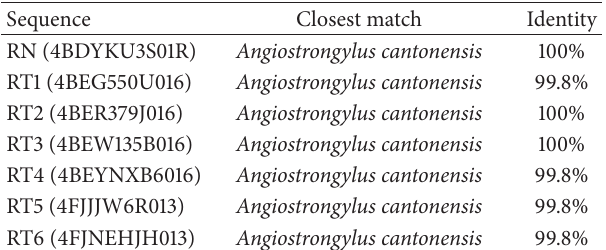
Table 1: Adult worm sequences obtained in the study and their closest match in